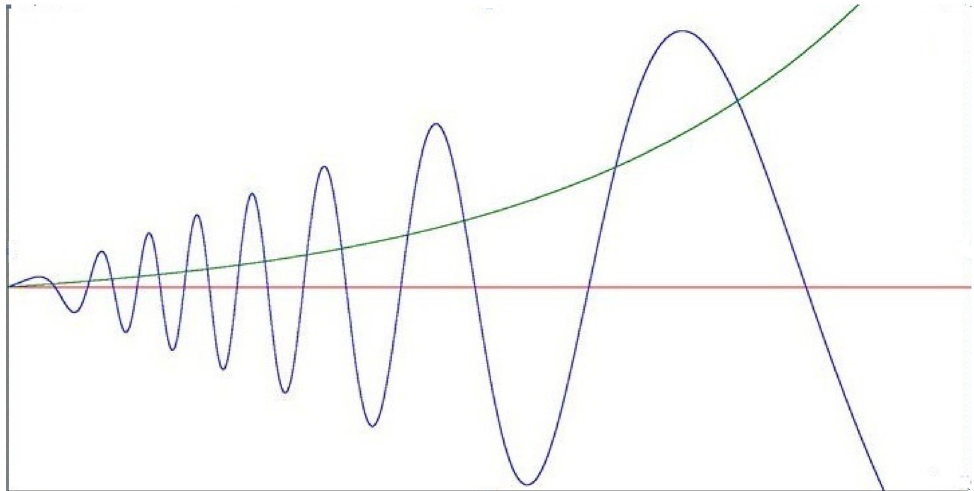
Figure 2. The three different cases of a regime change. Figure based on Economou et al. (2016). Regime 2, as depicted by the ongoing series of (blue color) curves in Figure 2,